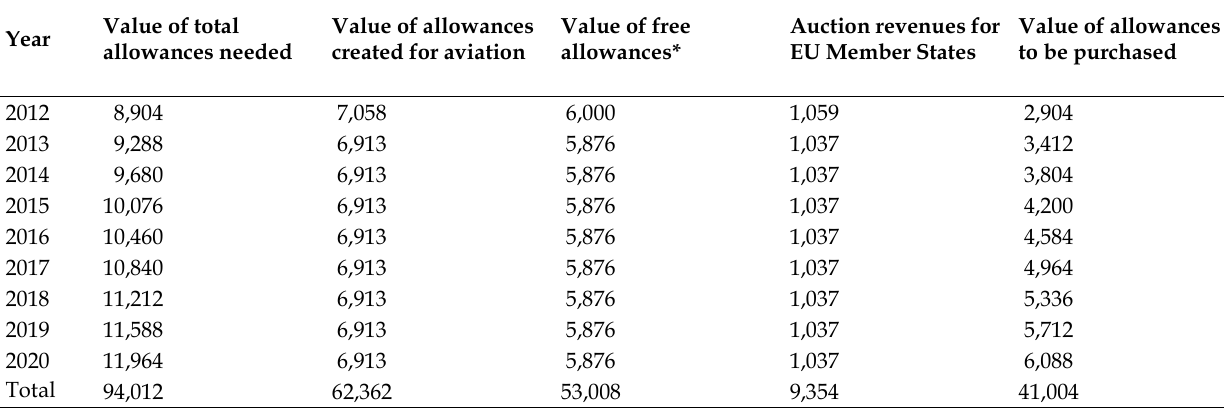
Table 4. Cost impacts of the EU ETS for aviation, 40 € per tonne, in million